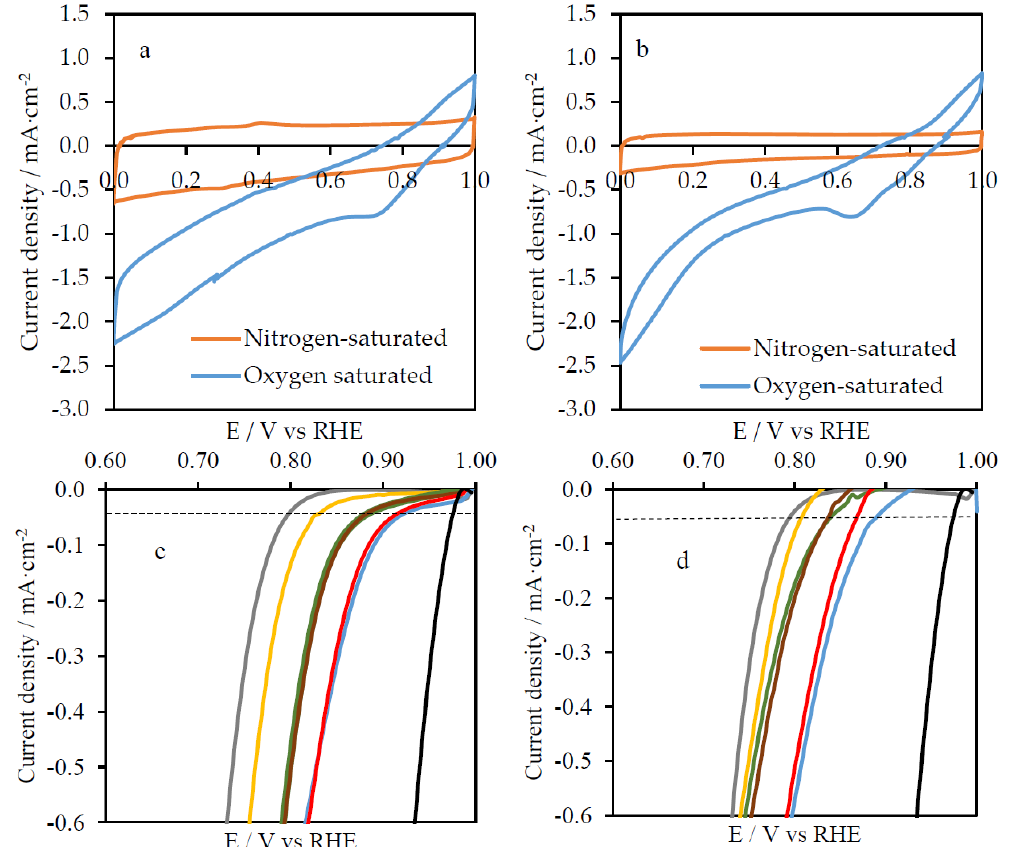
Figure 6. Steady voltammograms in nitrogen- and oxygen-saturated 0.1 M KOH solution at 50 mV·s −1 of ( a ) G/Si-PANI-5min-900 and ( b ) G/Ti-PANI-5min-900. Linear sweep voltammetry curves in O 2 - saturated 0.1 M KOH solution at 50 mV·s −1 for ( c ) G/Si-PANI-X-900 and ( d ) G/Ti-PANI-X-900 samples. In linear sweep voltammetry (LSV) curves, grey represents G, yellow represents G/X, green represents G/X_900, brown represents G/X_PANI_10s_900, blue represents G/X-PANI_30s_900, and red represents G/X_PANI_5min_900, with X being ( c ) Si or ( d ) Ti. Black line represents the commercial Pt/C catalysts, included for comparison purposes.